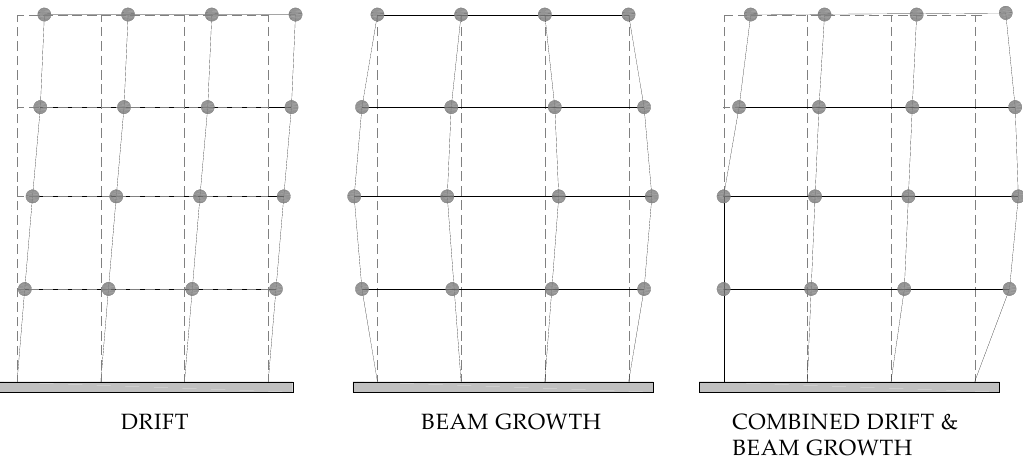
Figure 23. Frame sway including beam growth [46].